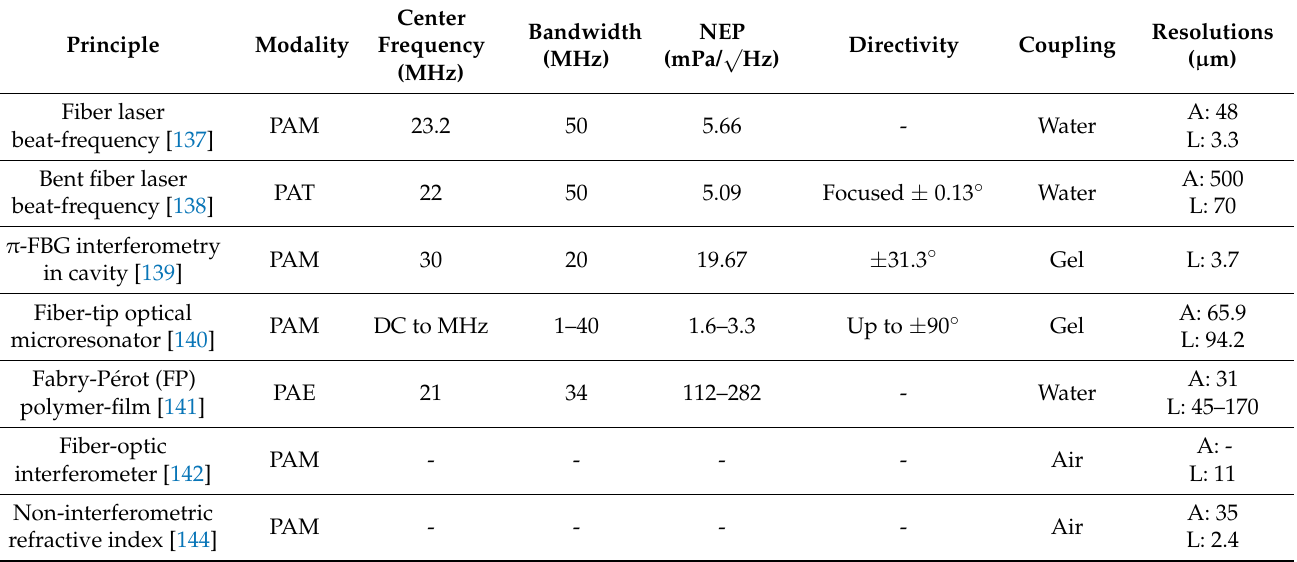
Table 1 summarized all the PAI systems by using optical-fiber detections, as mentioned above. Table 1. Optical fiber based ultrasound detections in PAI. NEP, noise equivalent pressure; A, axial resolution; L: lateral